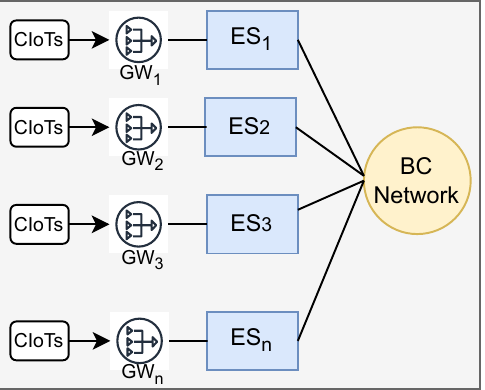
Figure 1. Basic connectivity of components in the proposed